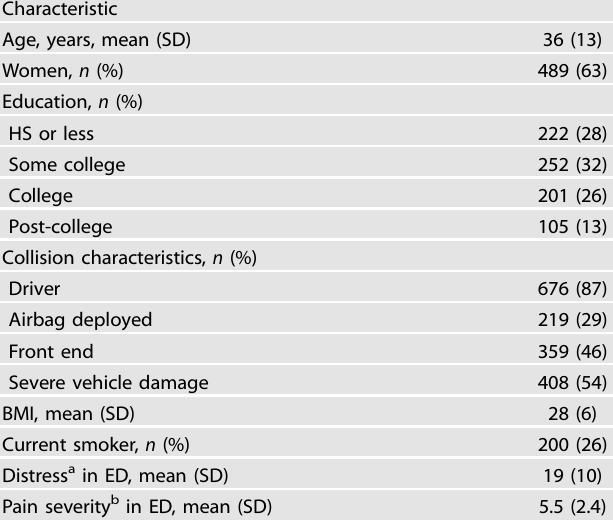
Table 1. Baseline characteristics of target cohort ( n =